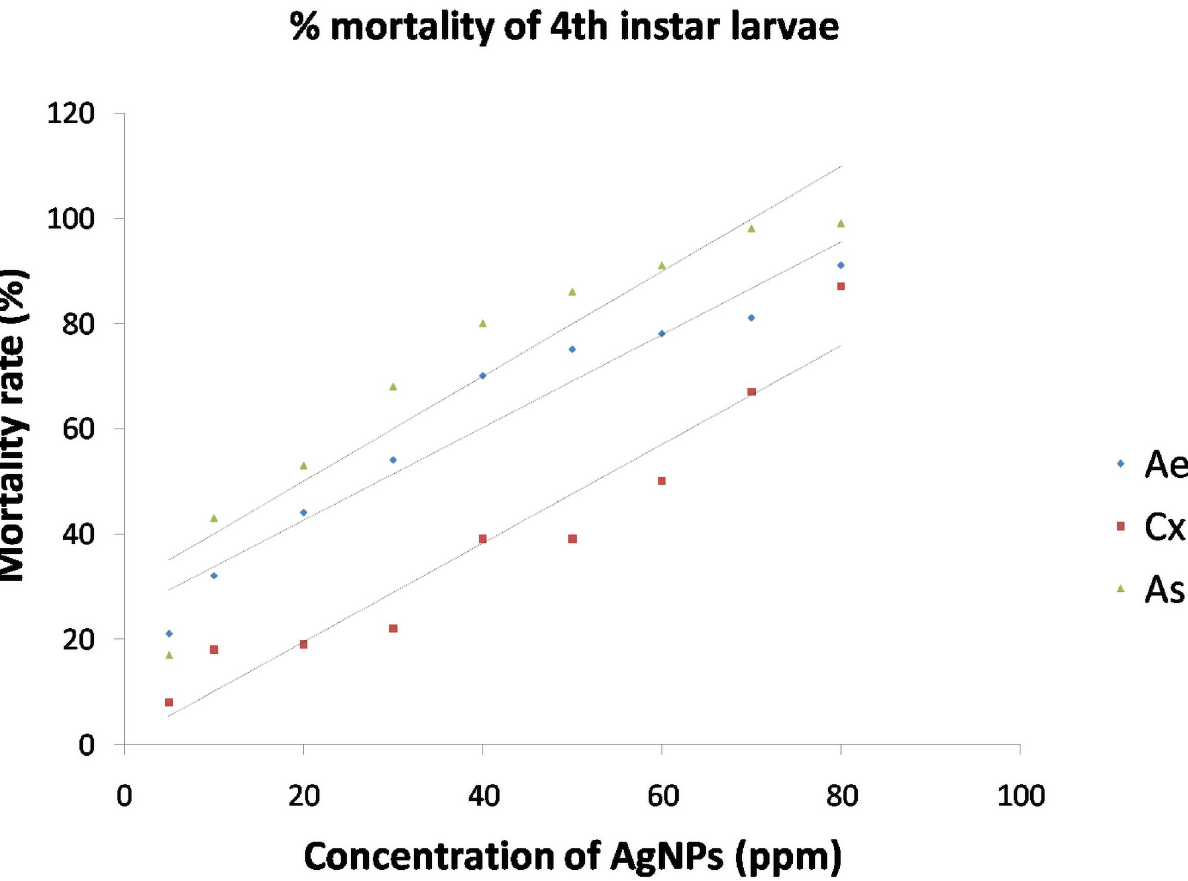
Fig 11. Mortality curves for pupicidal activity of AgNPs synthesized by Bacillus marisflavi against the pupae of Ae . aegypti , Cx . quinquefasciatus and An . Stephensi